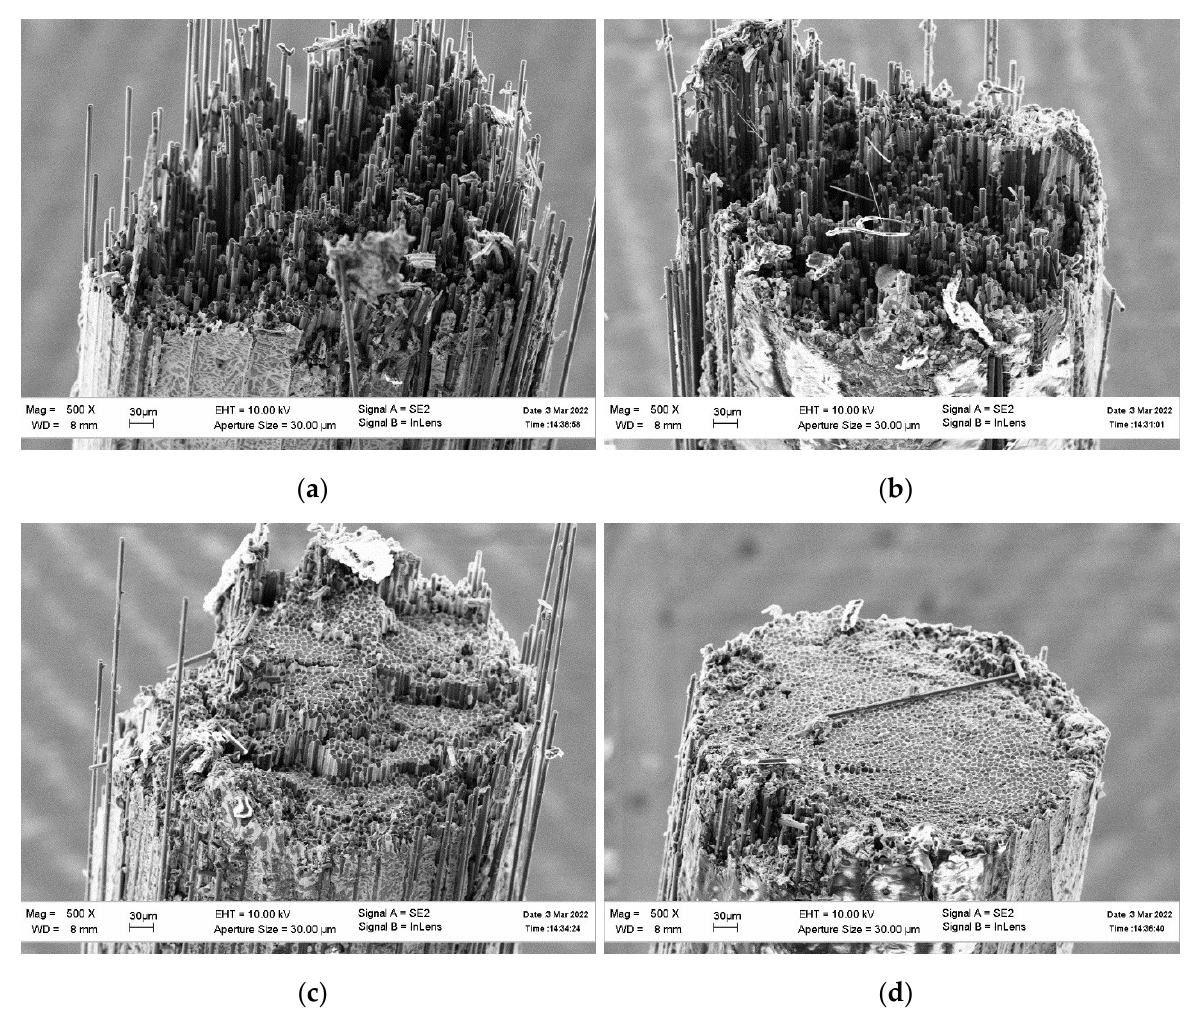
Figure 7. Fracture surfaces of the composite wire in an initial state ( a ) and after heat treatment at 500 °C ( b ), 550 °C ( c ), and 600 °C ( d ).